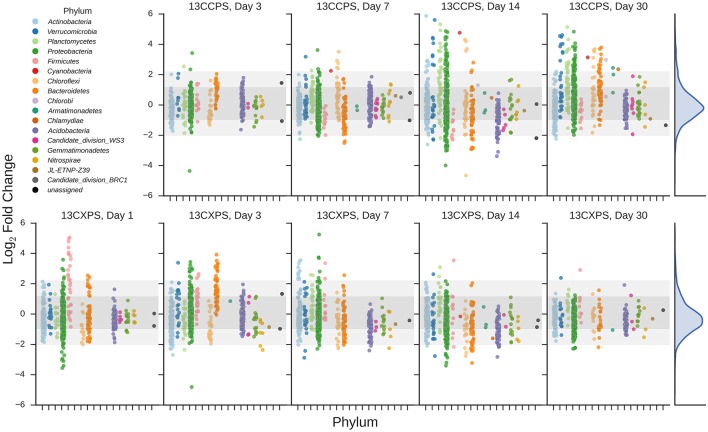
Enrichment of OTUs in either 13C-cellulose (13CCPS, upper panels) or 13C-xylose (13CXPS, bottom panels) treatments relative to control, expressed as LFC (see Methods). Each point indicates the LFC for a single OTU. High enrichment values indicate an OTU is likely 13C-labeled. Different colors represent different phyla and different panels represent different days. The final column shows the frequency distribution of LFC values in each row. Within each panel, shaded areas are used to indicate one standard deviation (dark shading) or two standard deviations (light shading) about the mean of all LFC values.